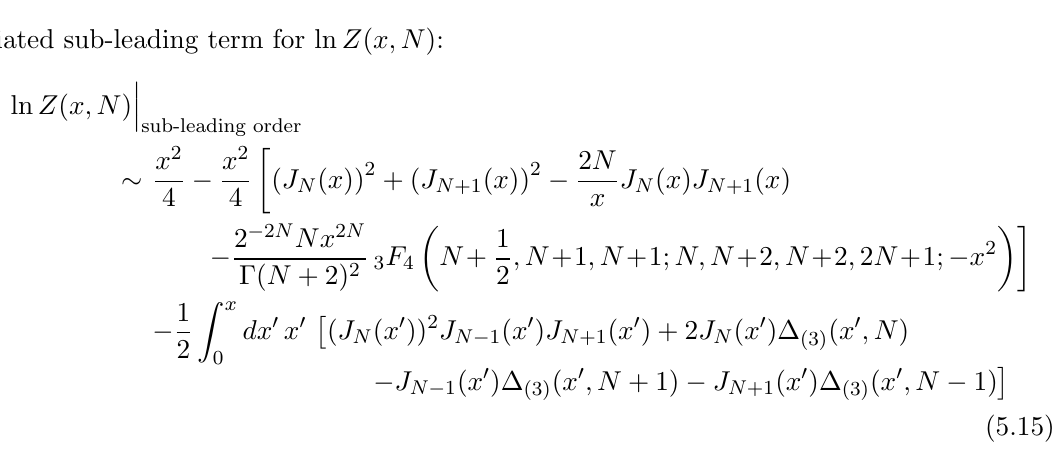
Figure 6 . Comparison plots of the exact ln Z ( x; N ), with the trivial x 2 = 4 term subtracted [solid blue curve], as a function of x , for N = 5, compared to successive terms in the strong-coupling trans-series expansion. The red dashed curve includes just the (cid:12)rst non-trivial term, from (5.9), while the black dot-dashed curve includes also the next term in (5.15). The agreement is excellent in the strong-coupling x ! 0 region, even in the transition region x (cid:25) N , and improves progressively as more terms in the instanton sum are